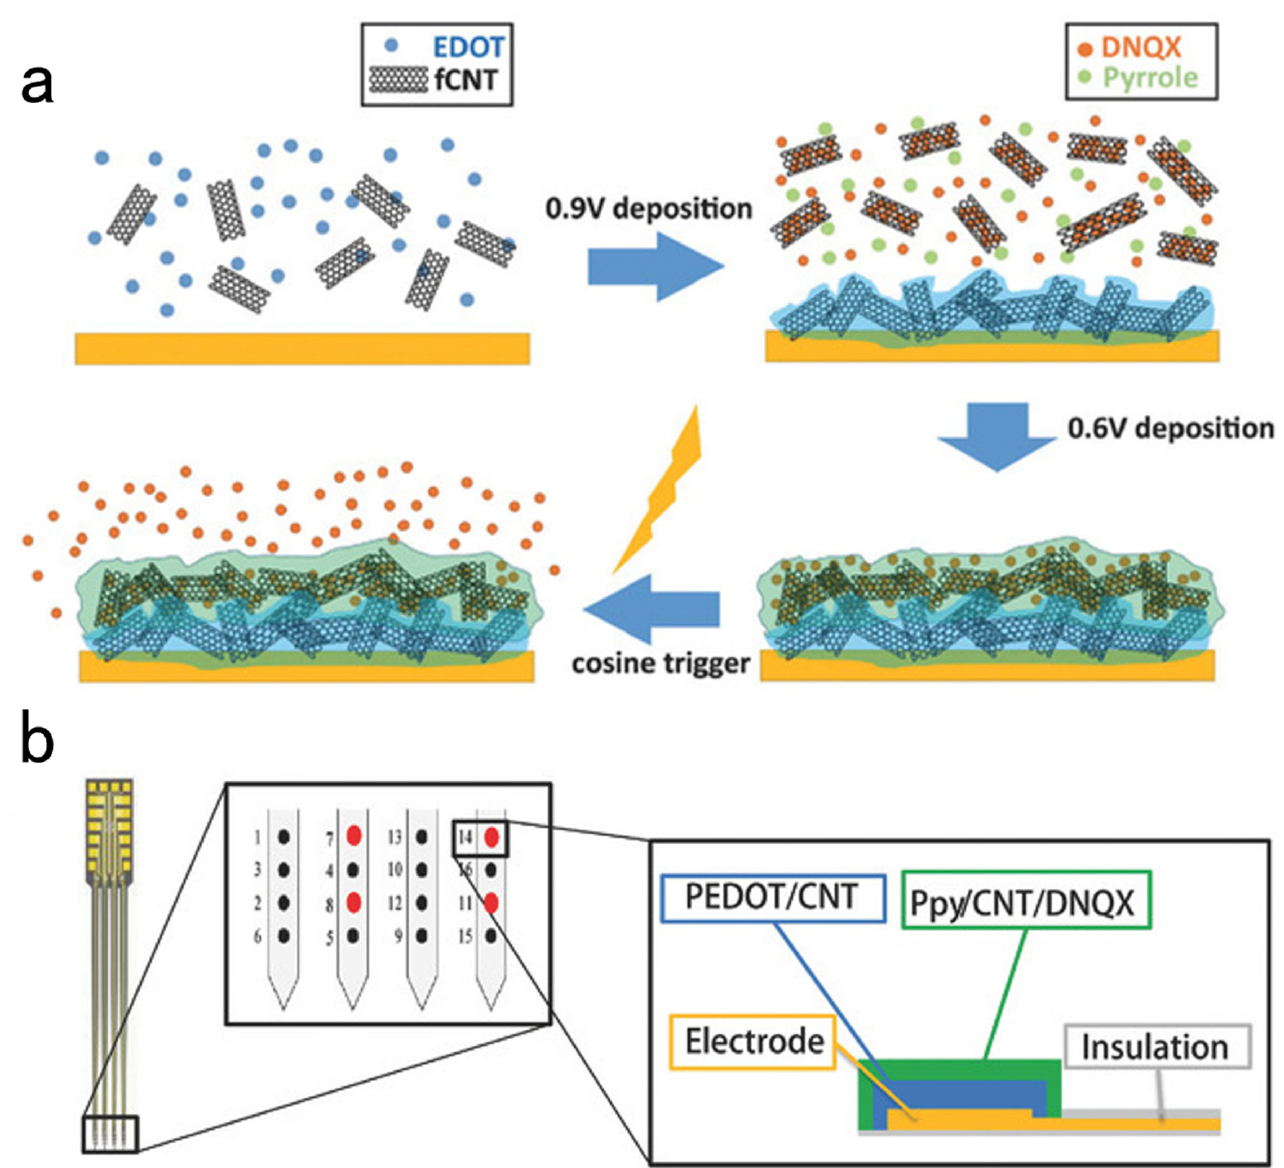
Figure 10. ( a ) Synthesis of the PEDOT/fCNT-PPy/fCNT/DNQX double-layer membrane and controlled release of DNQX from the membrane. ( b ) Dual-layer coating design of MEA in vivo.